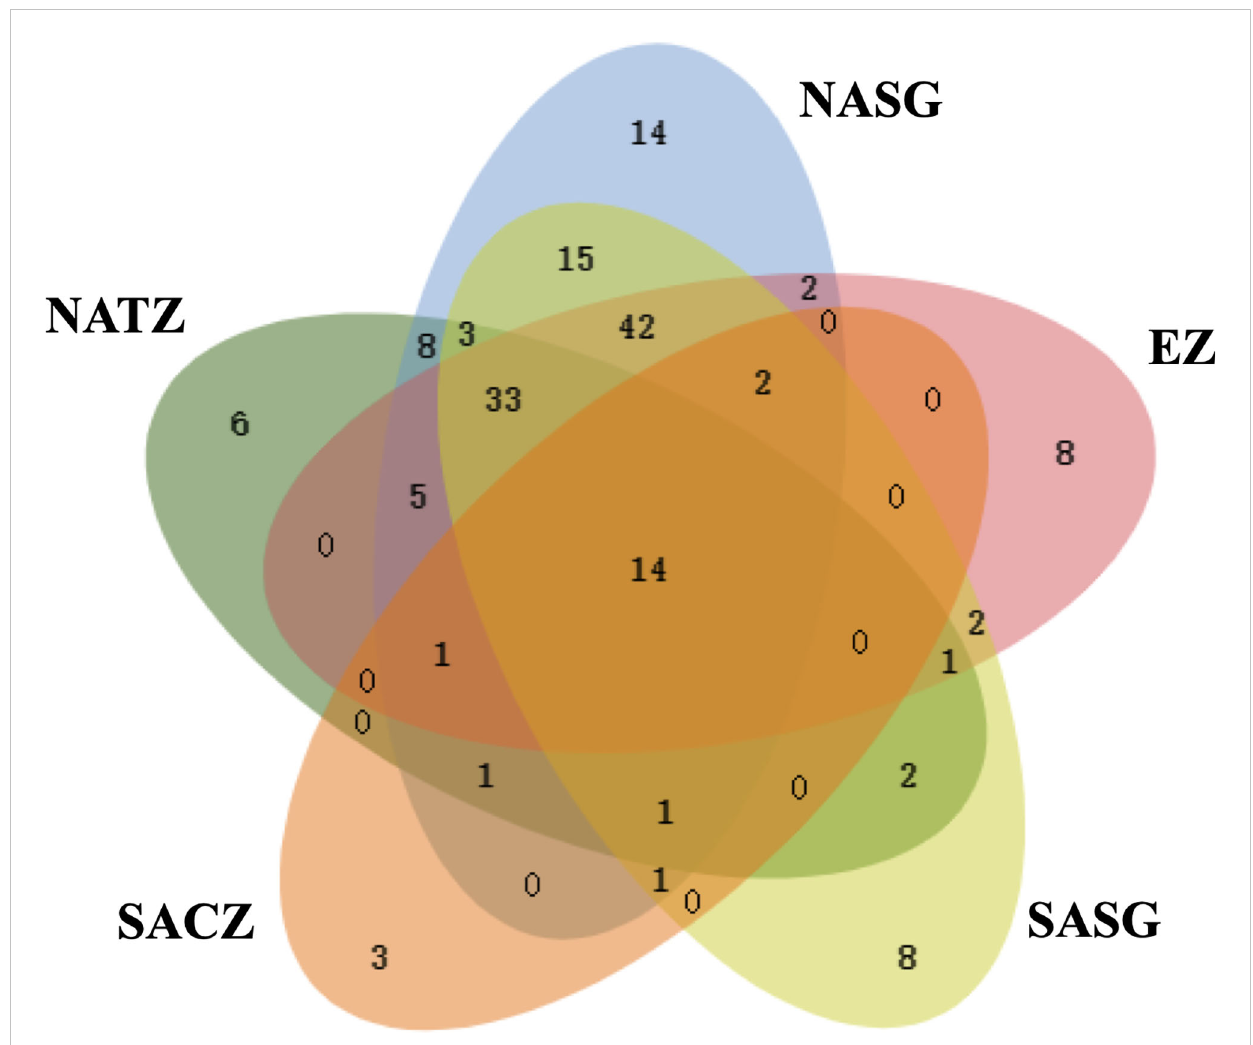
FIGURE 9 Venn diagram showing the number of Tintinnina species that are unique and shared among the fi ve oceanic provinces. NATZ, North Atlantic Transition Zone; NASG, Northern Atlantic Subtropical Gyre; EZ, Equatorial Zone; SASG, Southern Atlantic Subtropical Gyre; SACZ, South Atlantic Convergence